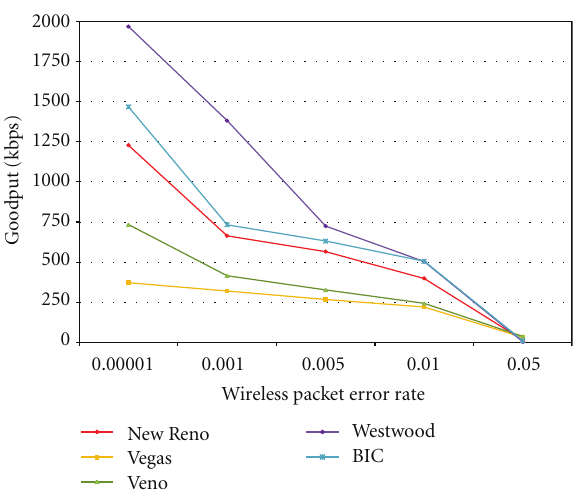
Figure 7: Goodput versus PER in WiMAX for the Scenario 2. Figure 8: Goodput versus queue size of the bottleneck link in WiMAX for Scenario 2 (PER = 10 (cid:21) − 5